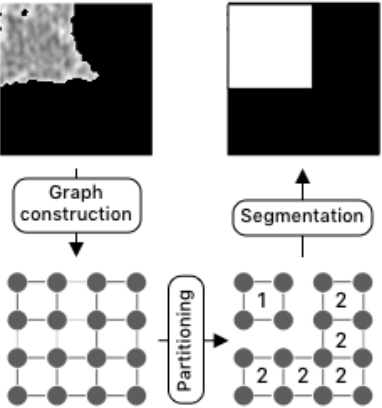
Figure 12. An overview of graph-based segmentation. First, a graph is segmented from the image such that the vertices are a sampling of the points on the image, and the edges are weighted based on the similarity of the two points they connect. In the figure, darker edges are weighted more heavily. The graph is then partitioned into connected components using some criterion that discards low-weighted edges. Finally, the partitioned graph is used to segment the original